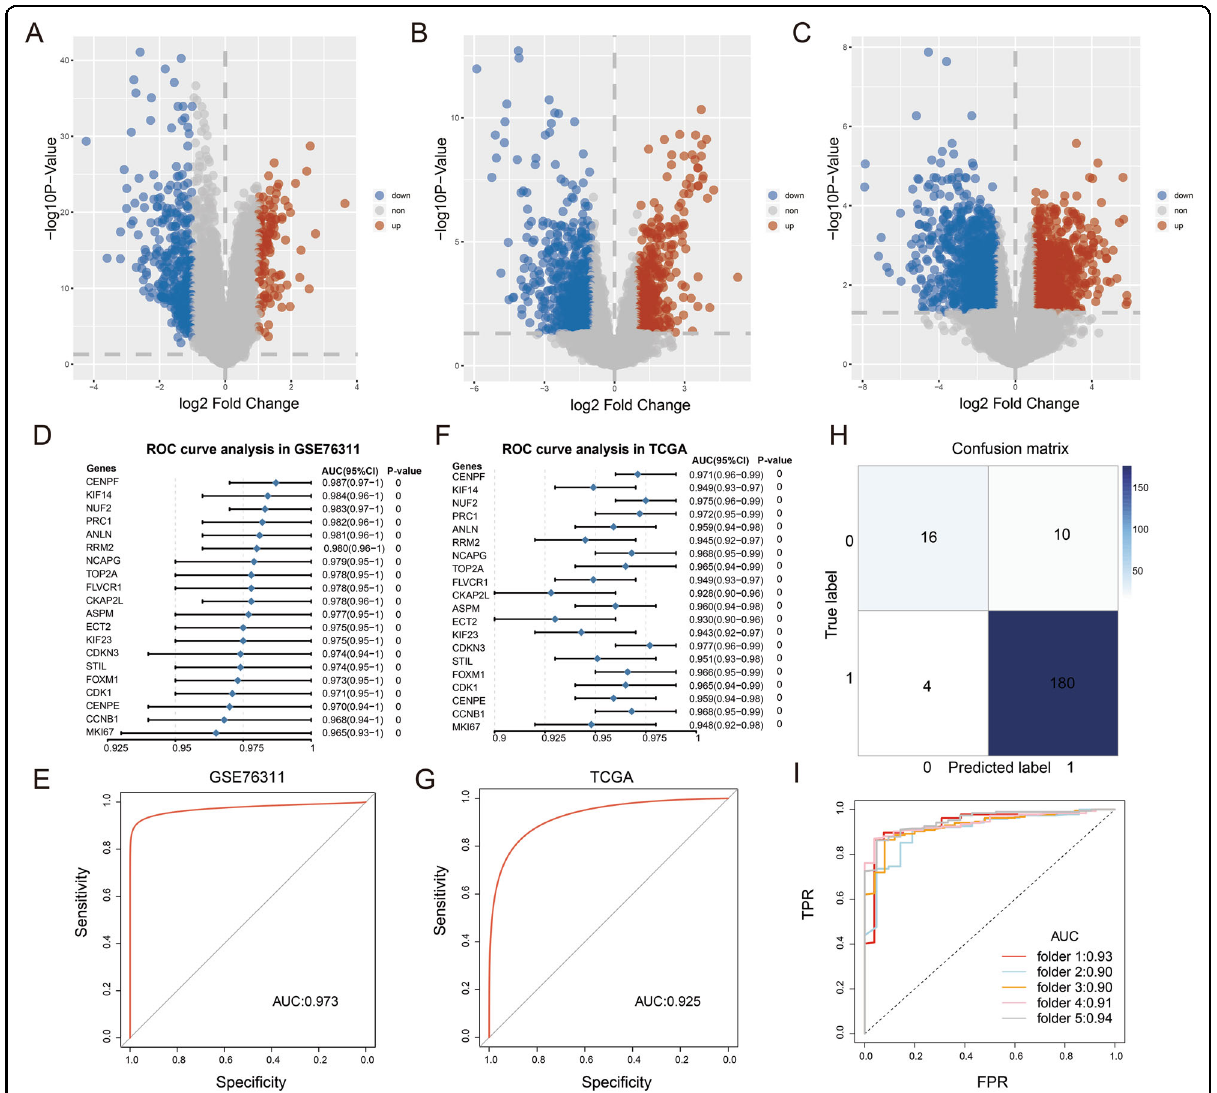
Fig. 1 Volcano maps of DEGs and identi fi cation of hub genes. A Volcano map of DEGs in the GSE76311 cohort. B Volcano map of DEGs in the GSE101685 cohort. C Volcano map of DEGs in the GSE101728 cohort. D Forest map of hub genes in the GSE76311 cohort. E ROC curve of the value of ECT2 in predicting diagnosis in the GSE76311 cohort. F Forest map of core genes in the TCGA cohort. G ROC curve of the value of ECT2 in predicting diagnosis in the TCGA cohort. H Confusion matrix of the ECT2 gene. I ROC curve of the fi vefold cross-validation of the ECT2